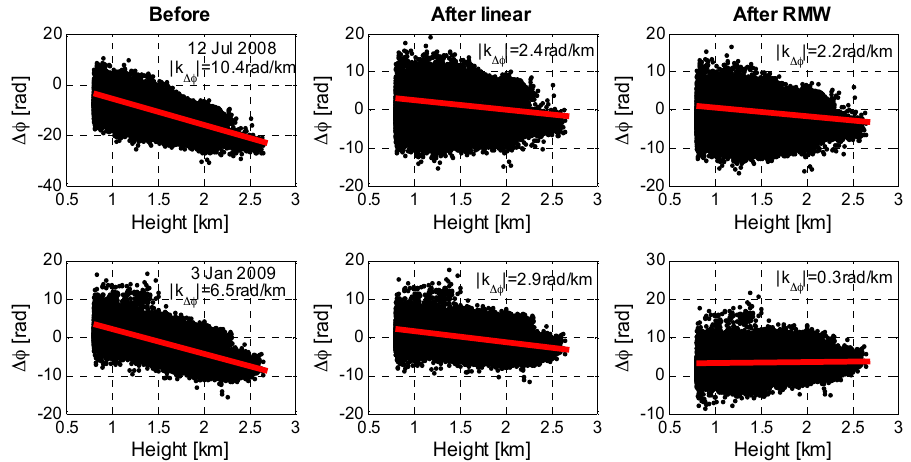
Figure 6. Scatterplots of the local correlation between interferograms and topography. A comparison of the estimated ratio k Δ φ (red solid line) before and after correction for tropospheric delays using the linear and RMW methods for the 12 July 2008 and 3 January 2009 interferograms.